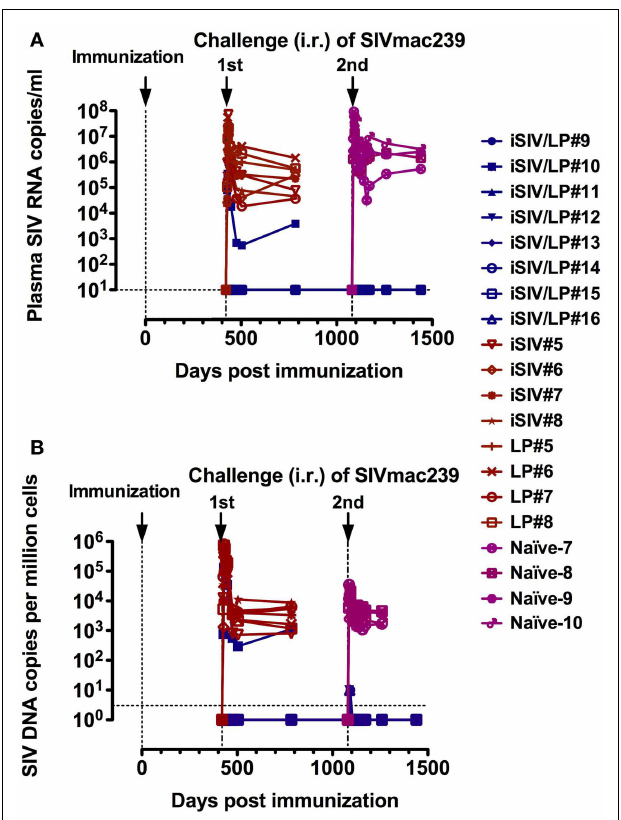
FIGURE 3 | Long-term follow-up of eight macaques intragastrically immunized with iSIV and LP and eight control monkeys immunized with iSIV alone (four macaques) or LP alone (four macaques) . (A,B) Plasma viral loads (A) and PBMC proviral loads (B) of eight macaques submitted to two successive intrarectal challenges performed at 14 and 36months post-immunization with SIVmac239